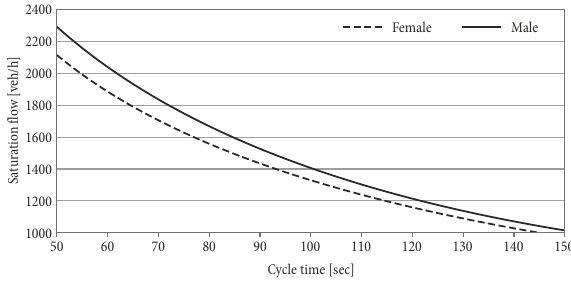
Fig. 8. Effect of gender on saturation